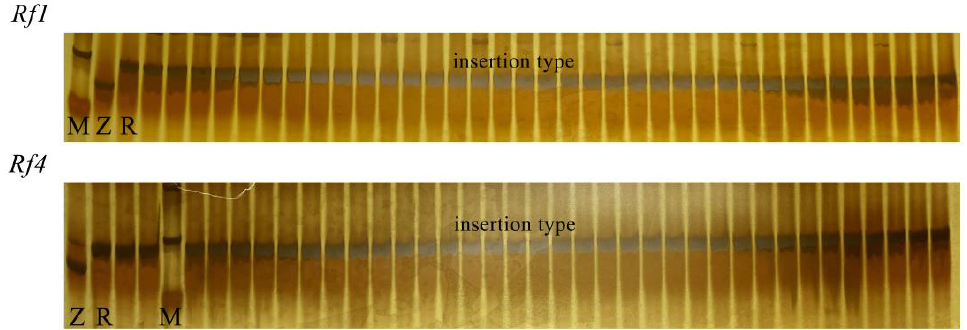
Figure 4. Detection of restorer genes RF 1 and RF 4 in 36 TF families. Z: Zhendao, R: R2027, M: DNA Marker 1.